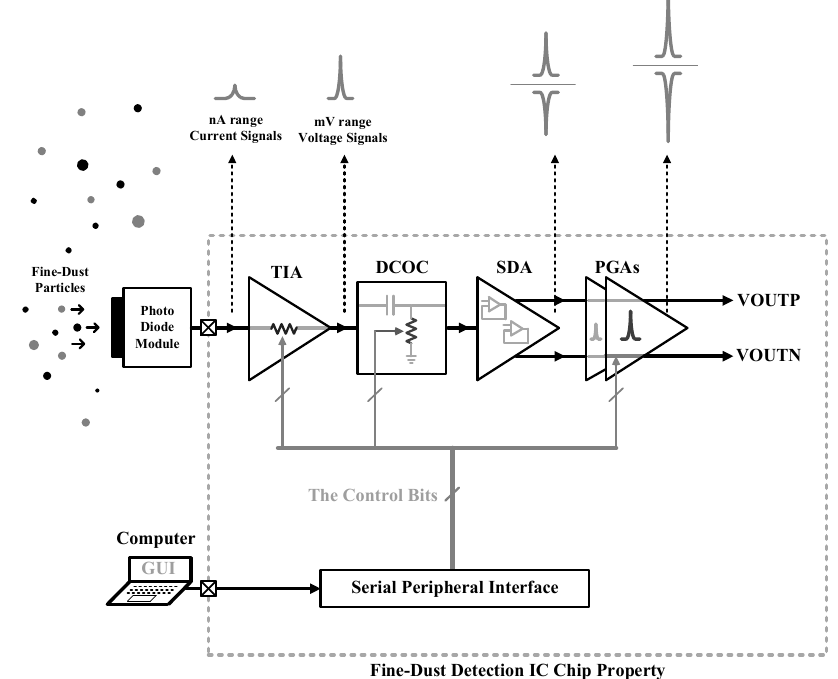
Figure 1. The top block-diagram of the fine-dust detection system IC.